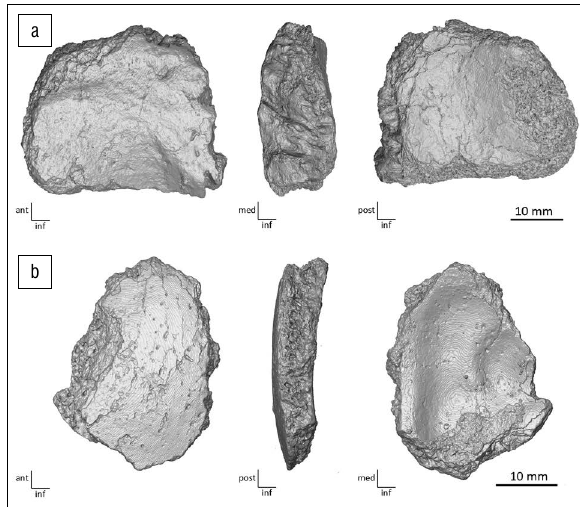
figure 1: Virtual rendering of (a) StW 671 and (b) StW 672 in ectocranial (left), posterior/medial (middle) and endocranial (right)